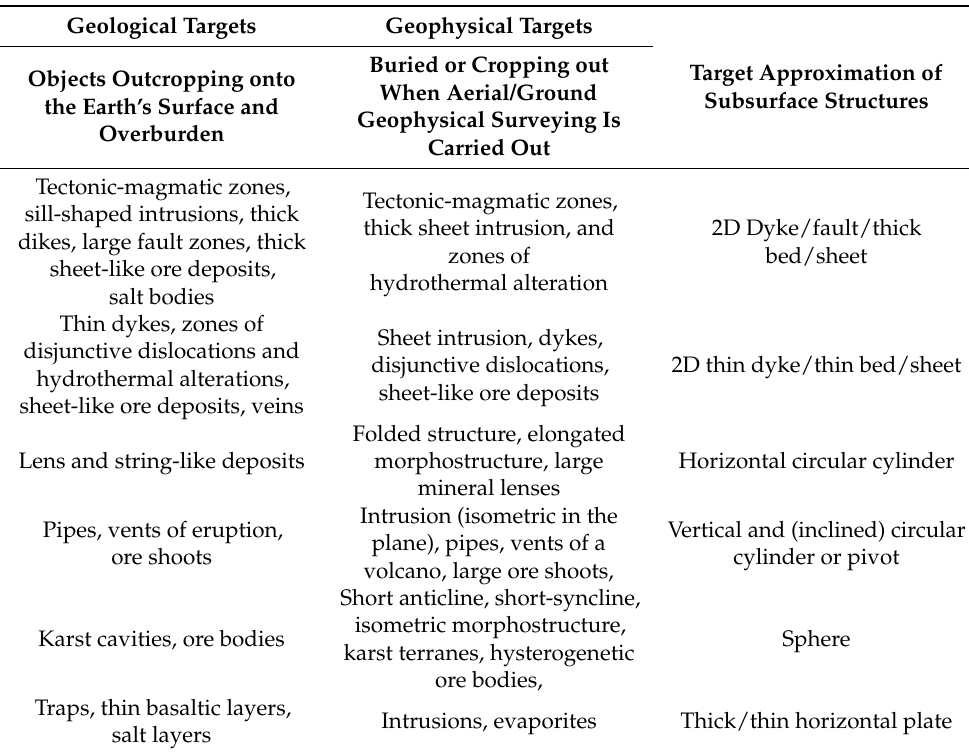
Table 1. Geological-Geophysical relationship and the target estimate for subsurface structures (modified after [66]). Geological